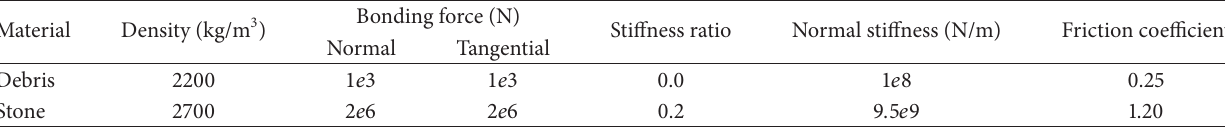
Table 1: The micromechanical parameters of outwash deposits.